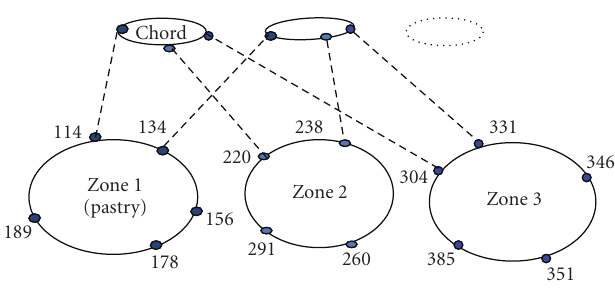
Figure 3: Overlay